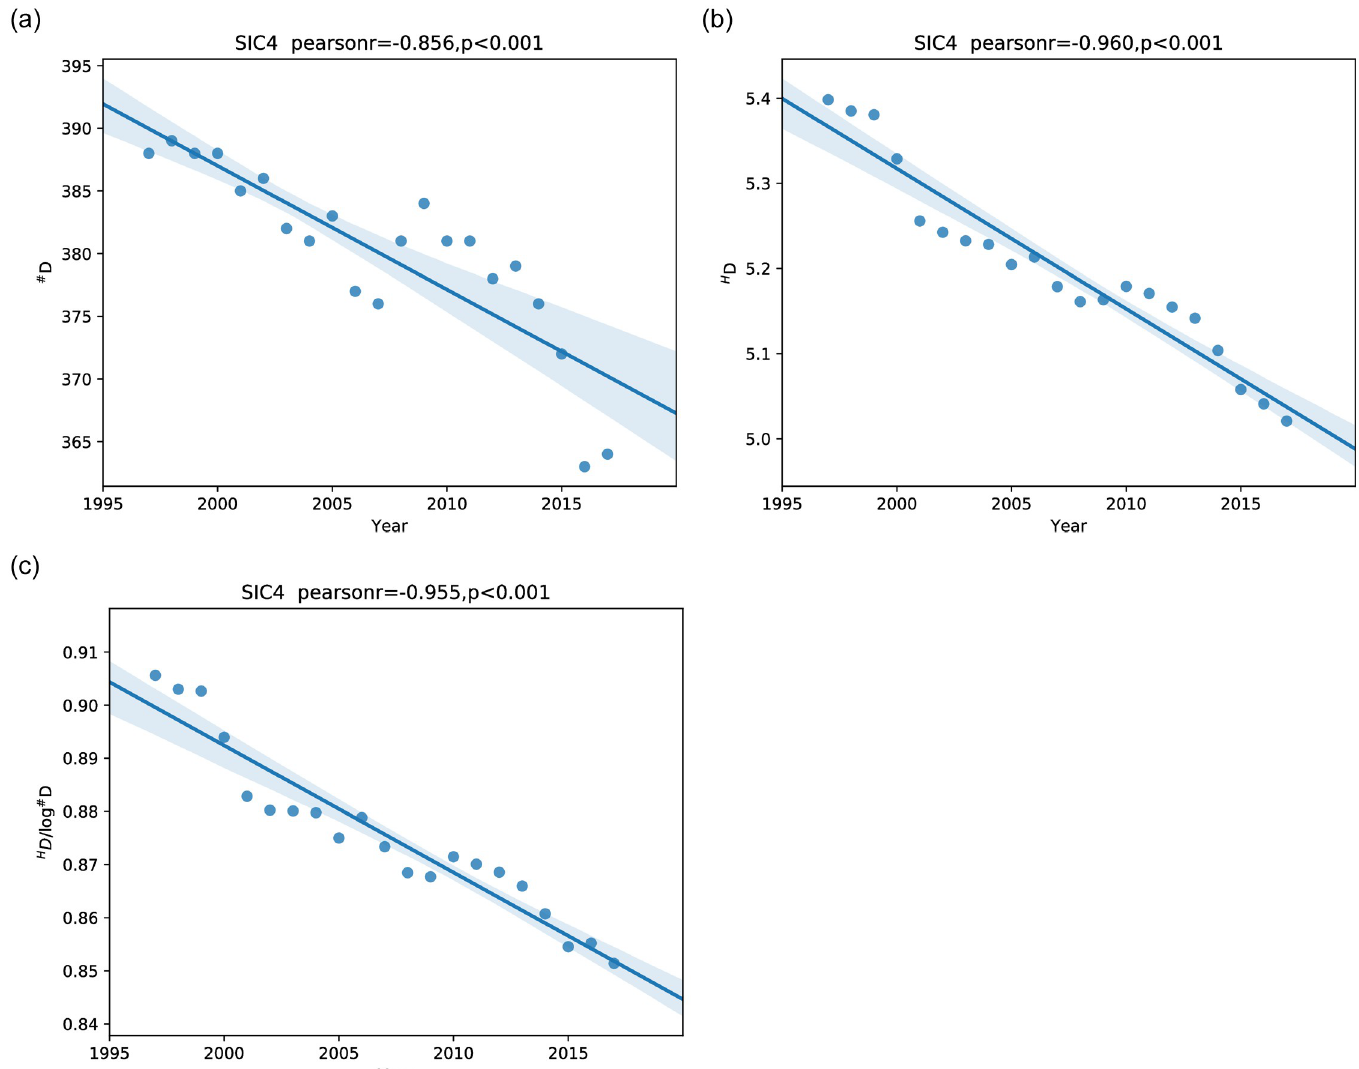
Fig 7. Left: The number of the 4-digit SIC Codes that are instantiated, during the first two decades of this century. Middle: Shannon entropy of the distribution of document counts per SIC Code during those years. Right: Normalized Shannon entropy of the same distribution during those years. Each plot includes a scatter plot of diversities and a linear regression fit with its 90% confidence